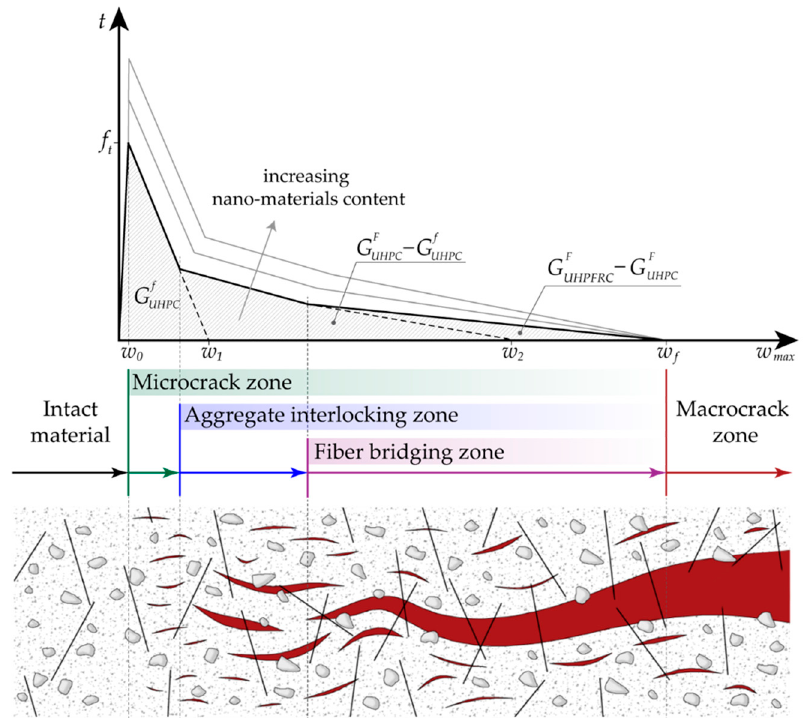
Figure 2. Traction–separation law for nano-enhanced UHPFRC with a trilinear softening model, and microscopic fracture mechanisms corresponding to each linear descending branch.